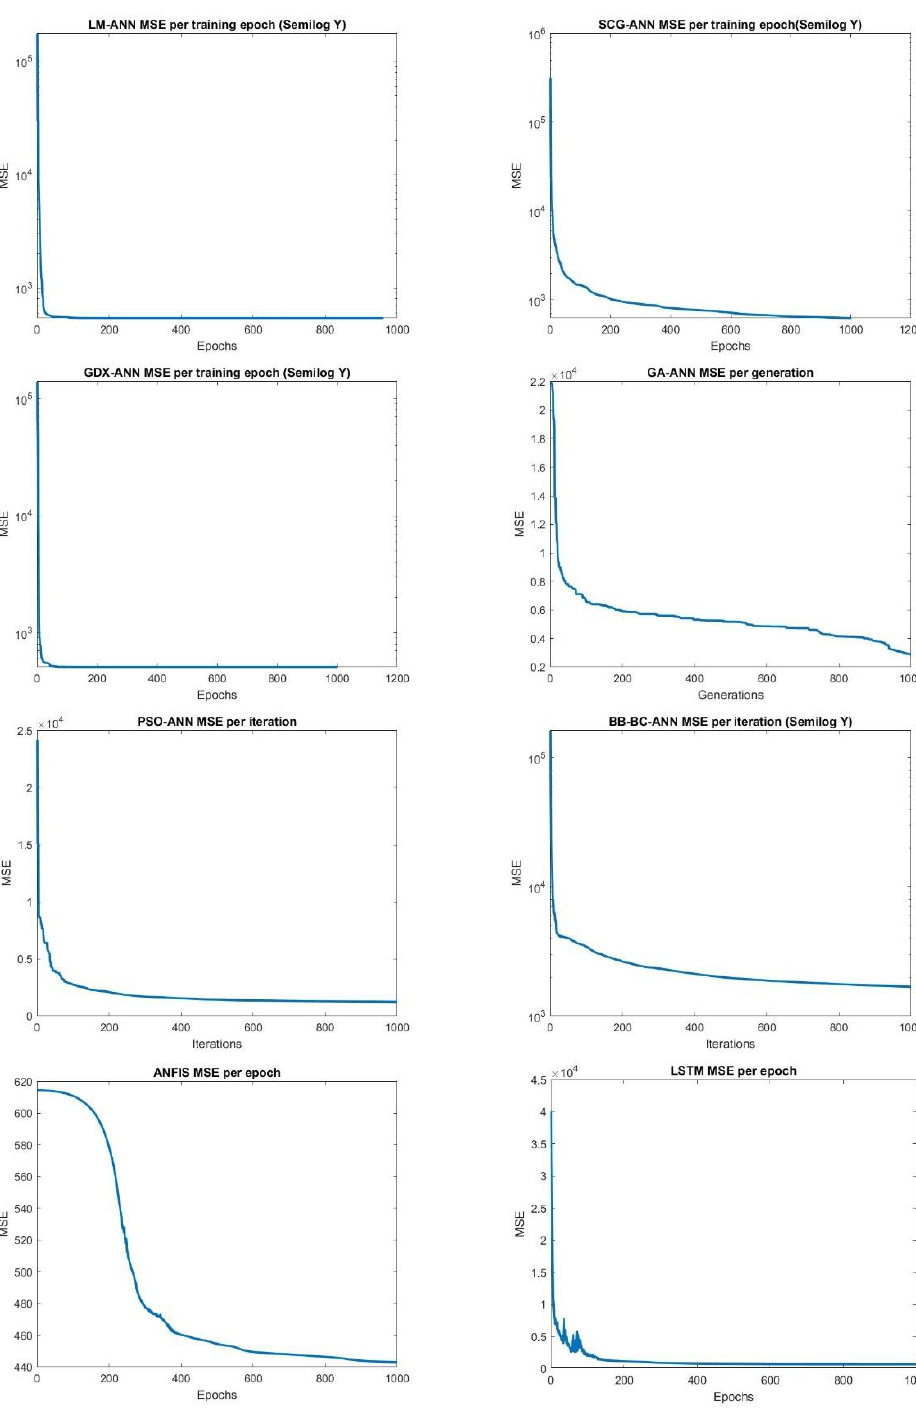
Figure 9. MSE versus number of iterations for the examined predictors. All predictors reached their best performance at the maximum number of epochs/it- erations except LM-ANN, which reached the best performance at 960 epochs, and ANFIS, which reached its best at 999 epochs. During training, the MSE of the LM-ANN predictor starts from very high values of 10 6 ~10 5 and converges to MSE values near to best before